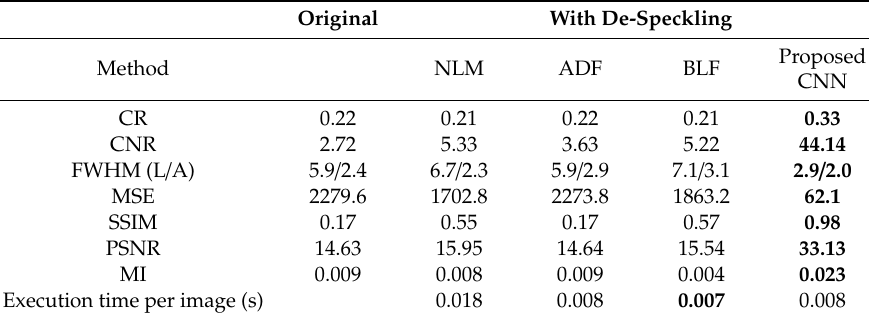
Table 7. Quantitative analysis of di ff erent de-speckling